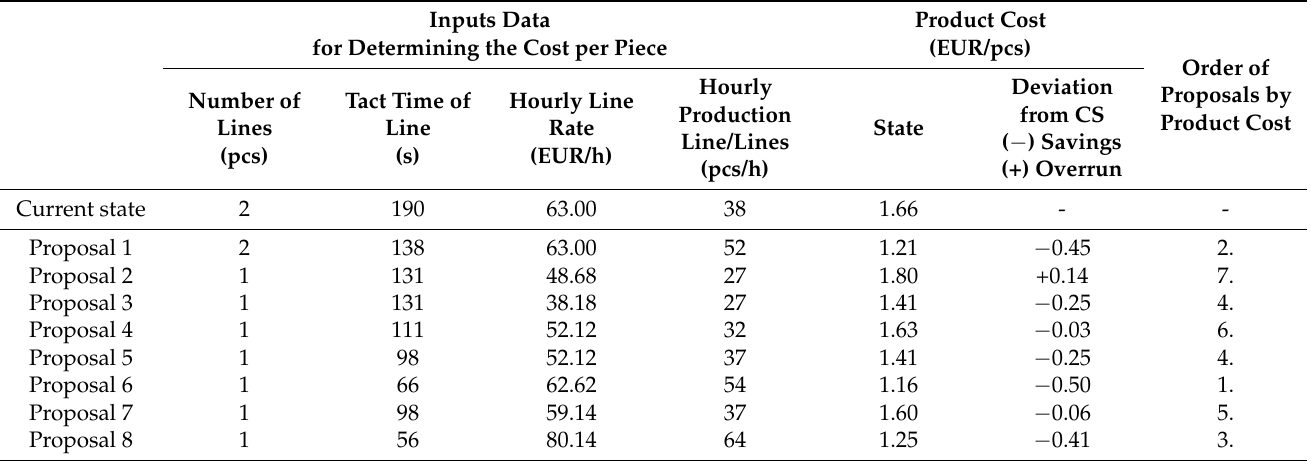
Table 18. Comparison of proposed solutions to the current state (CS) of the assembly process. Inputs